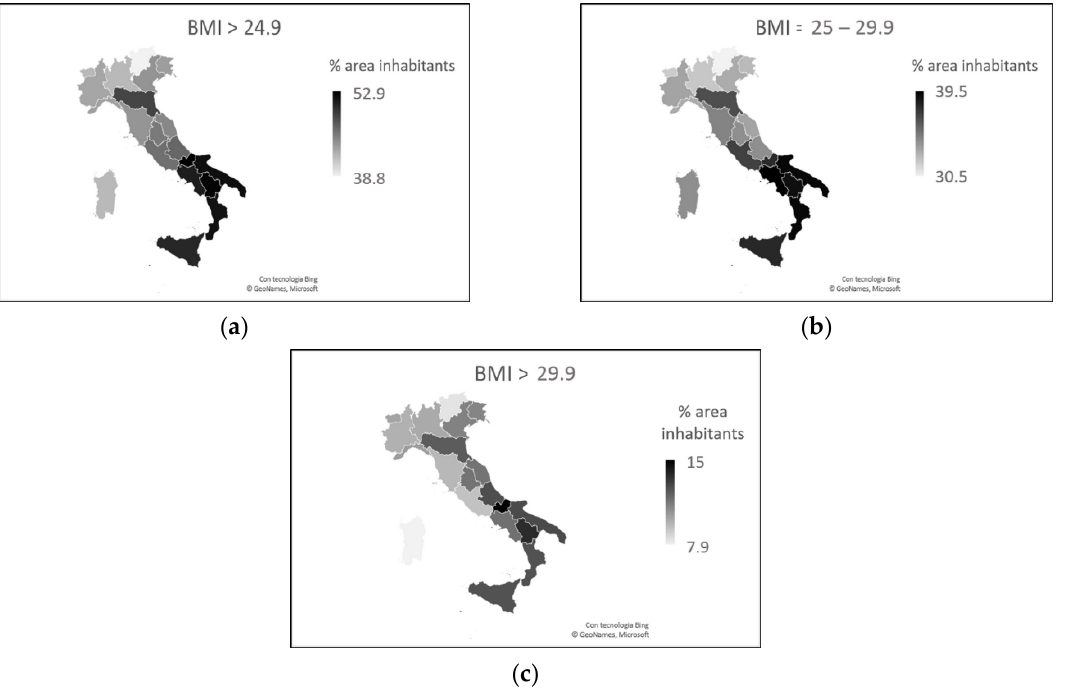
Figure 5. ( a ) Total percentages of weight problems in the individual regions, considering the adult population only. ( b ) Percentage of overweight adults in the various regions. ( c ) Percentage of obese adults in the various regions.